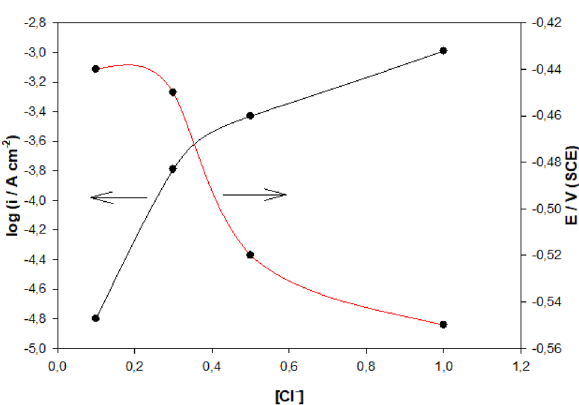
Figure 4. The variation of logi corr and E corr of Mo with Cl − concentrations in 3.0 M H 3 PO 4 solution at 298 K.